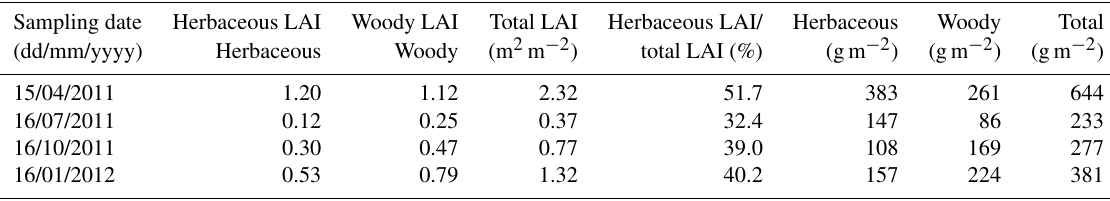
Table 2. One-sided leaf area index and leaf biomass within the flux footprint area in